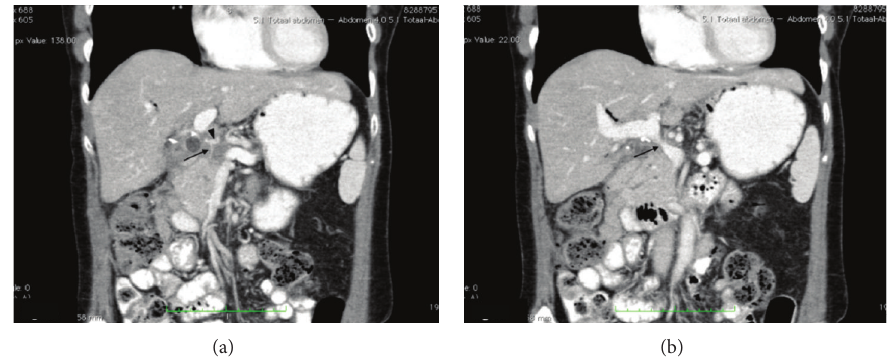
Figure 1: (a) 3 months interval portal venous-phase abdominal CT scan (coronal view). Status after exploratory laparotomy and 6 courses of chemotherapy. Note hypodensity in pancreatic head with encasement of the gastroduodenal artery (arrow) and common hepatic artery (arrowhead). (b) 3 months interval portal venous-phase abdominal CT scan (coronal view). Status after exploratory laparotomy and 6 courses of chemotherapy. Progressive stenosis of the portal vein can be noted (arrow).